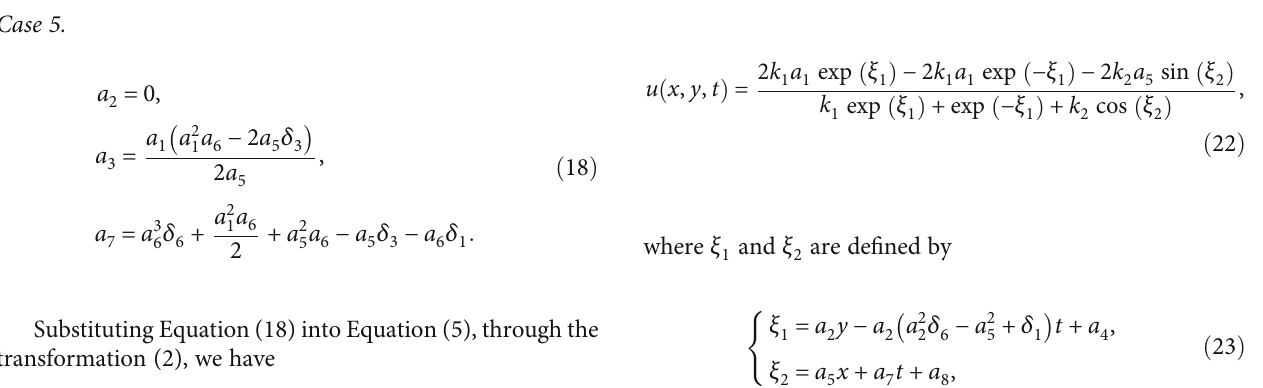
Figure 5: Spatiotemporal structure of solution (19) a = 1 , k = 1 , k = 1 , δ = 1 , and δ a 6 1 2 3